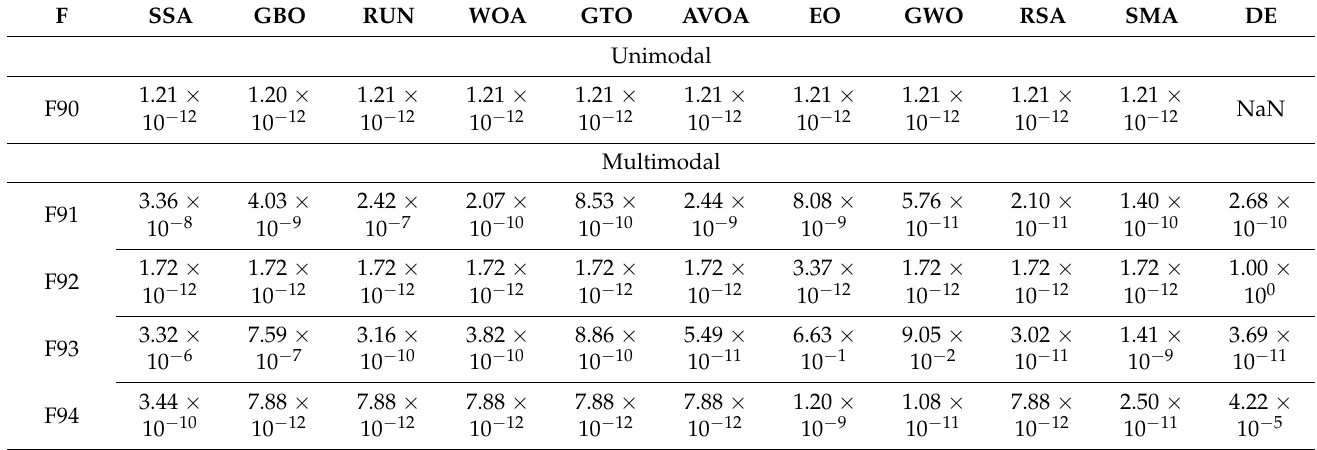
Figure 16. Average SD of each optimizer on all CEC2022. Table 15. p -values of LSO with each rival optimizer on CEC - 2022 test suite (F90-F101).